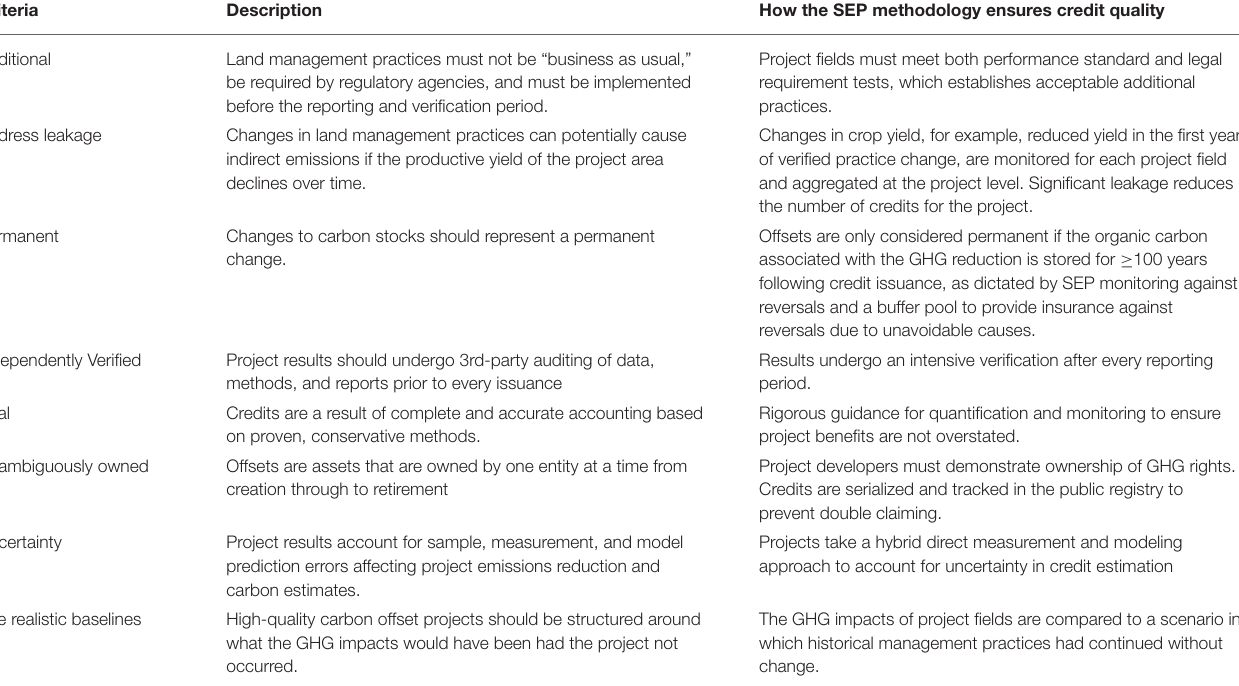
TABLE 1 | Requirements for high-quality carbon offset credits.